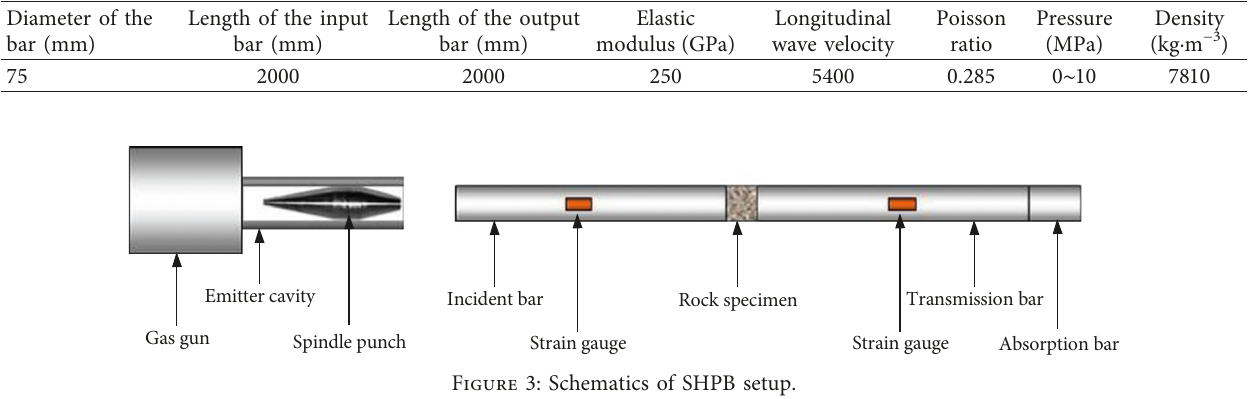
Figure 3: Schematics of SHPB setup.